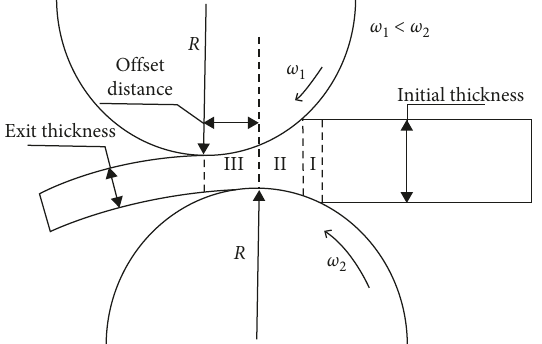
Figure 1: Schematic diagram of the deformation zone divided by contact conditions and the highest point of the lower work roll.